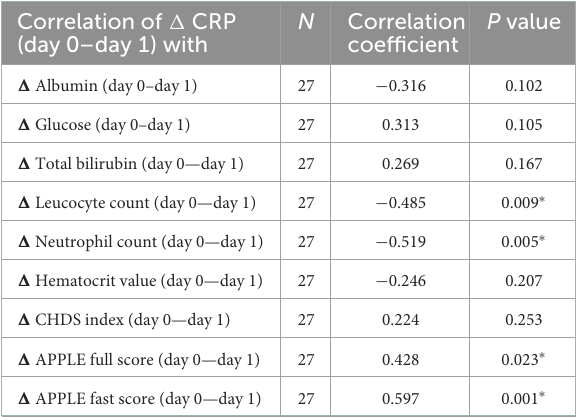
TABLE 3 Correlation of 1 C-reactive protein (day 0–day 1) with different variables. Correlation of 1 CRP (day 0–day 1) with